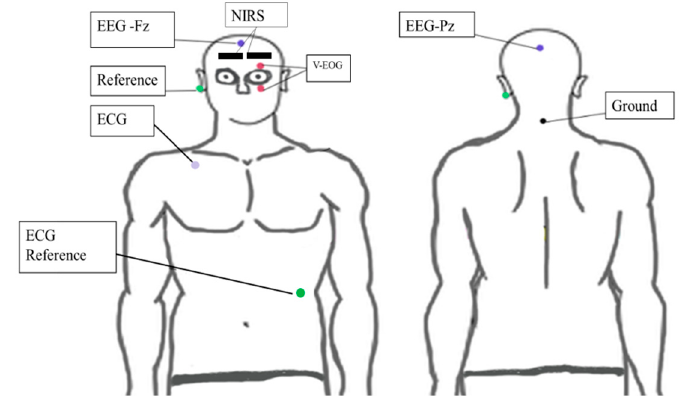
Figure 4. Hybrid system placement: EEG (Fz and Pz), ECG (2-lead placement), NIRS (Fp1 and Fp2).